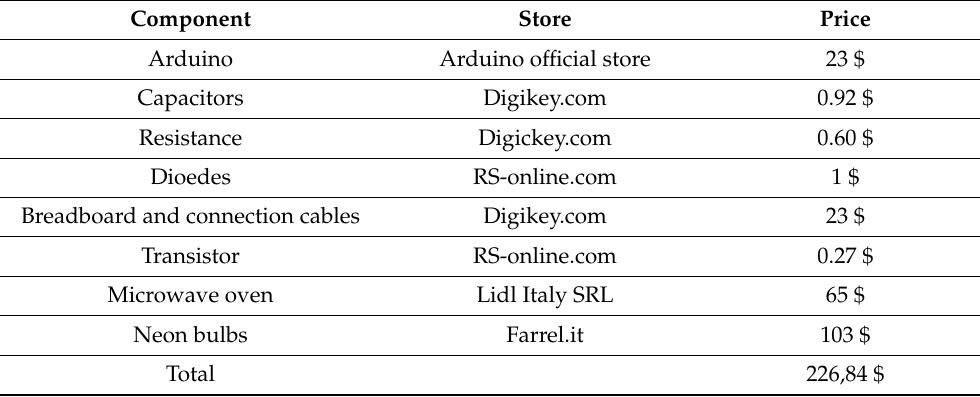
Table 1. Price list of electronic